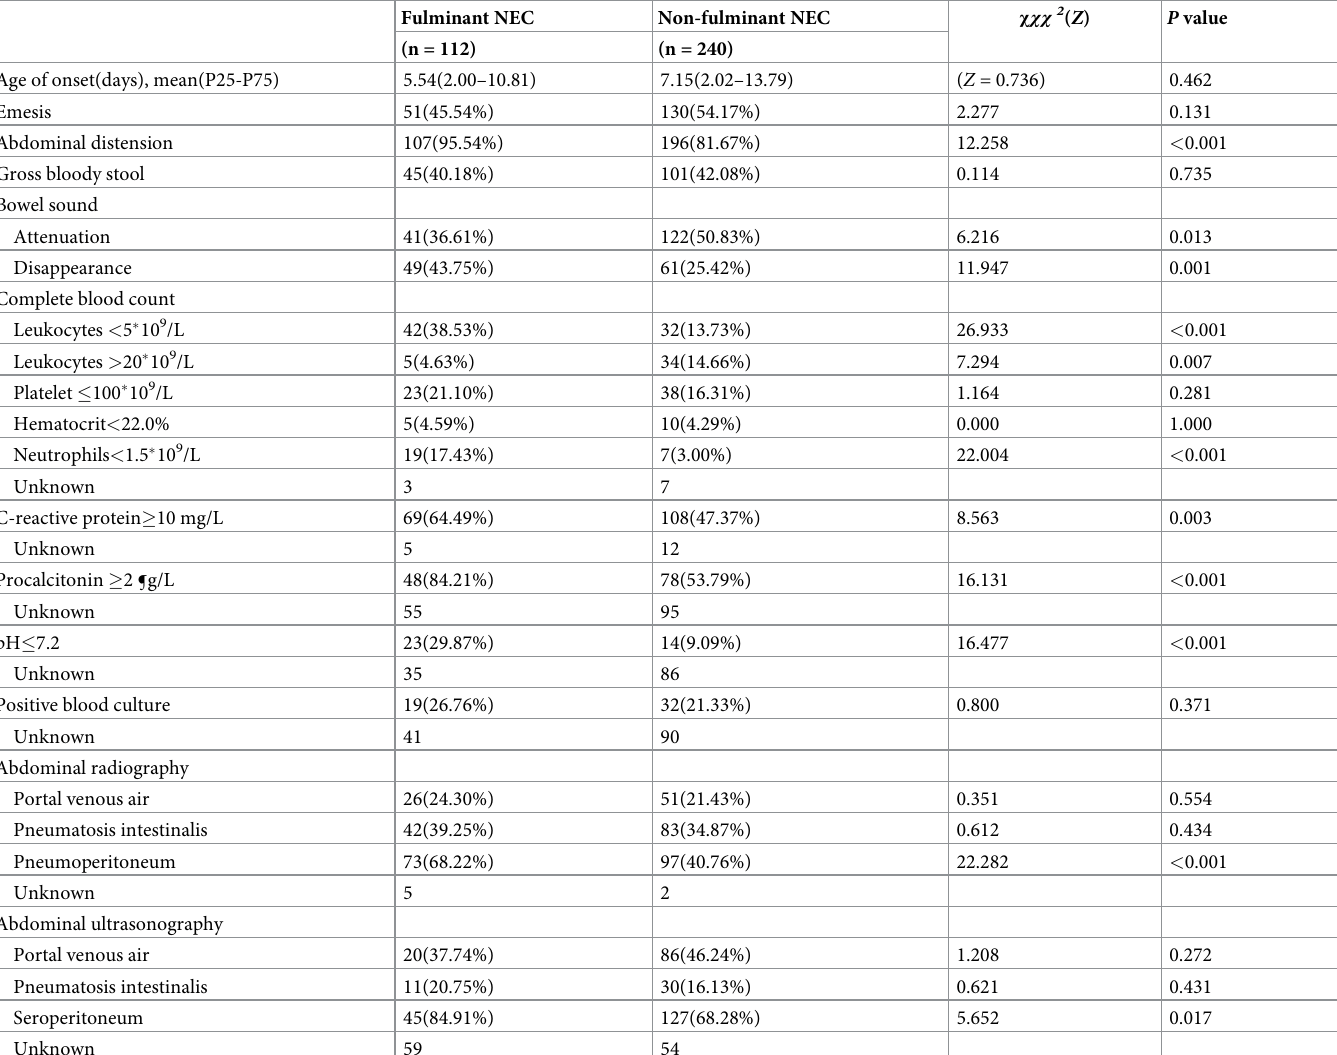
Table 2. Clinical features of the NEC